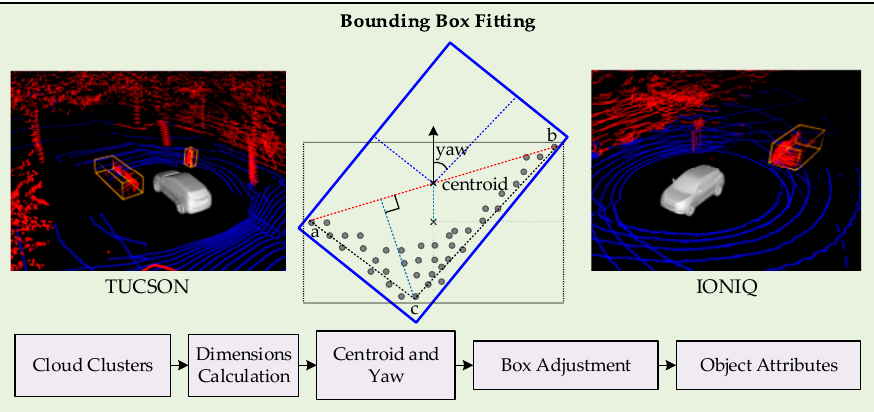
Figure 5. Dimensions, centroid, and yaw estimation of cluster for bounding box fitting and measurement generation. measurement